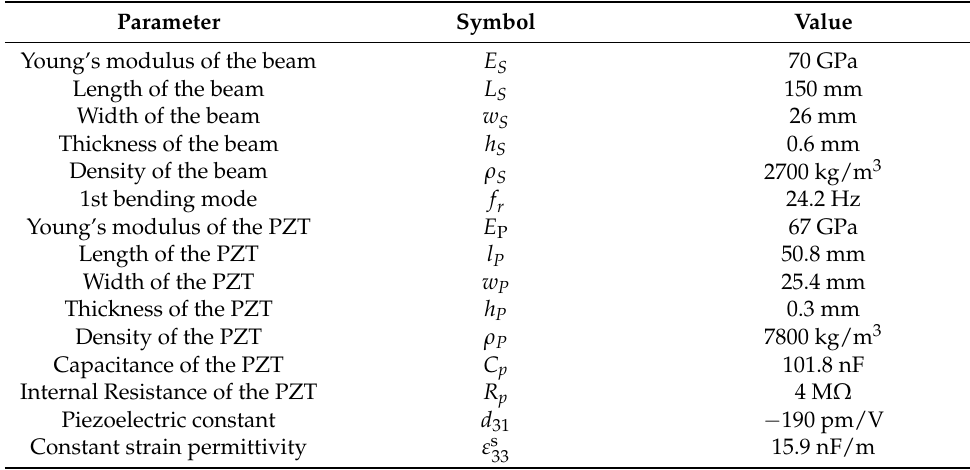
Table 2. Geometric and material parameters of the beam and